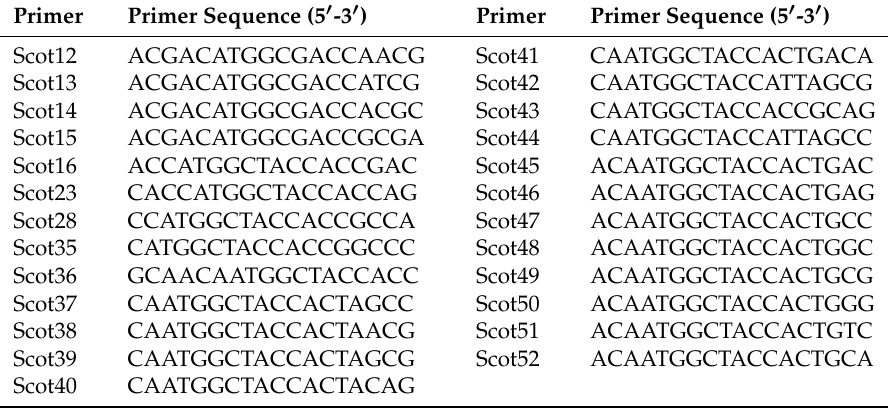
Table 5. Information for the 25 SCoT primers used in screening in materials.